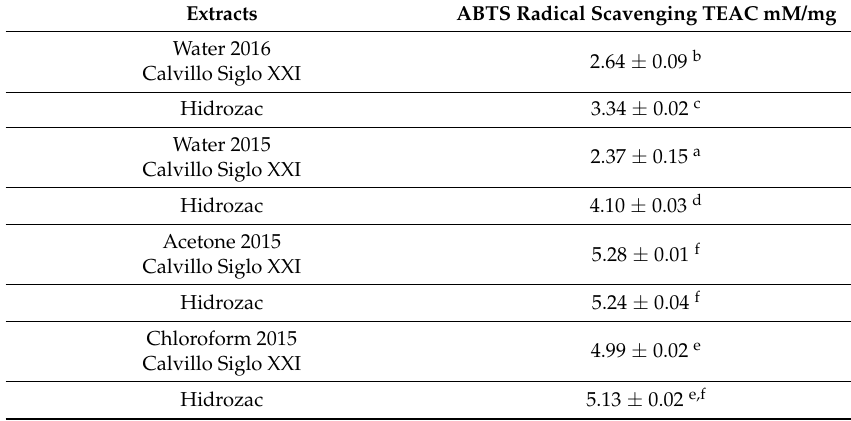
Table 4. ABTS radical scavenging ability in the aqueous, acetone, and chloroform extracts of the leaves of Calvillo Siglo XXI and Hidrozac. The average values ( ± SD) are expressed as antioxidant capacity equivalent to a millimolar of trolox per milligram of extract (TEAC mM/mg).